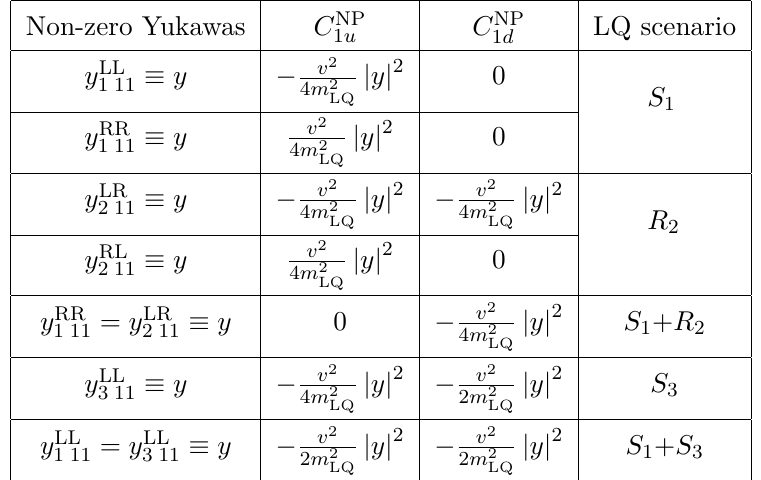
coefficients [40, 41] for the scalar leptoquark scenarios under consideration. The Table 5 . C NP 1 q mass and Yukawa coupling degeneracies of leptoquarks are understood while v = 246